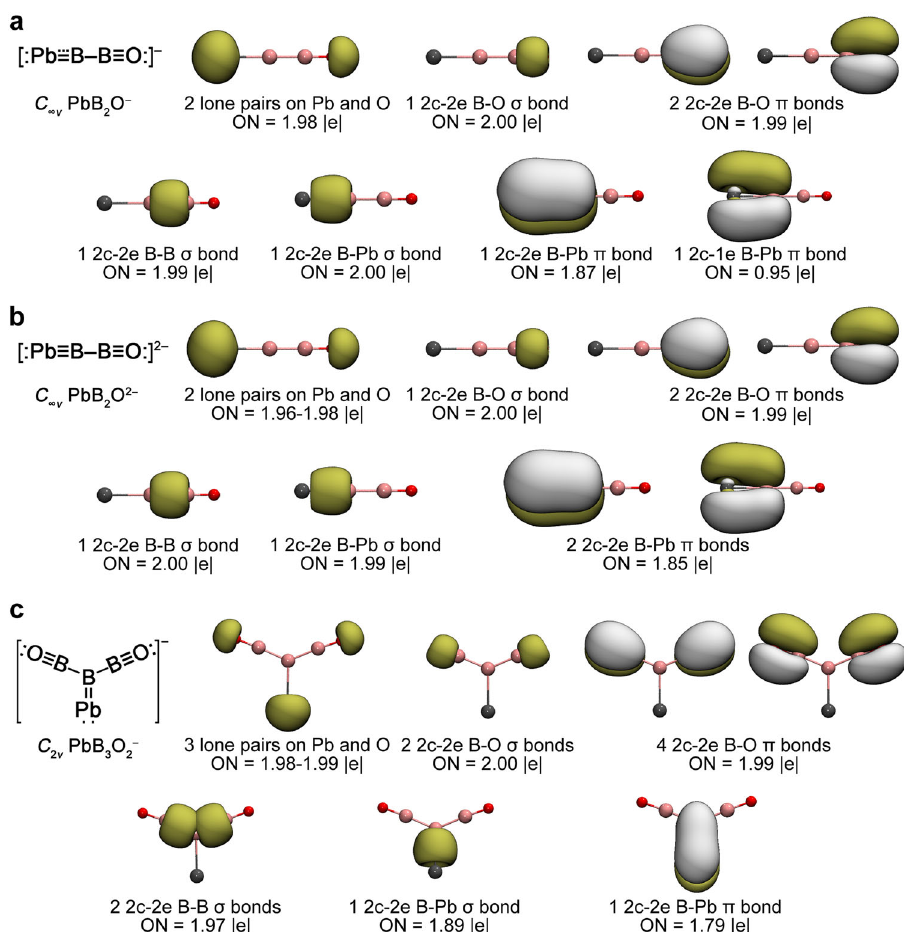
Fig. 4 Chemical bonding anaylses using AdNDP. a PbB 2 O – . b PbB 2 O 2 – . c PbB 3 O 2 – . The occupation numbers (ONs) are indicated. The corresponding Lewis electronic structures are also